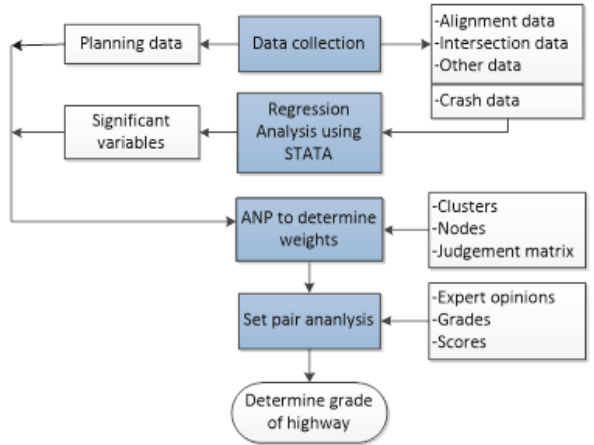
Figure 1: Logical steps of proposed integrated